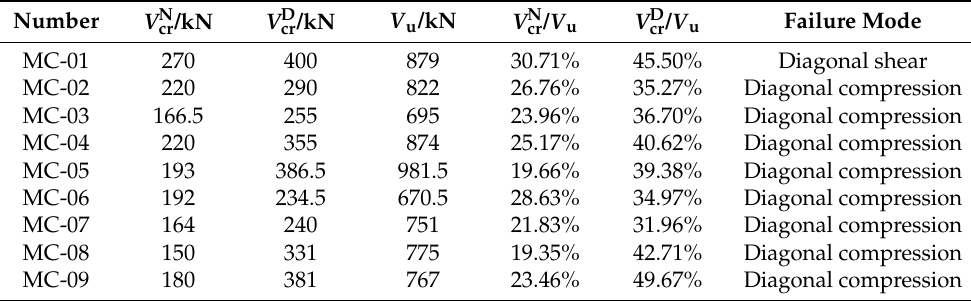
Table 4. Experimental results of the specimens.